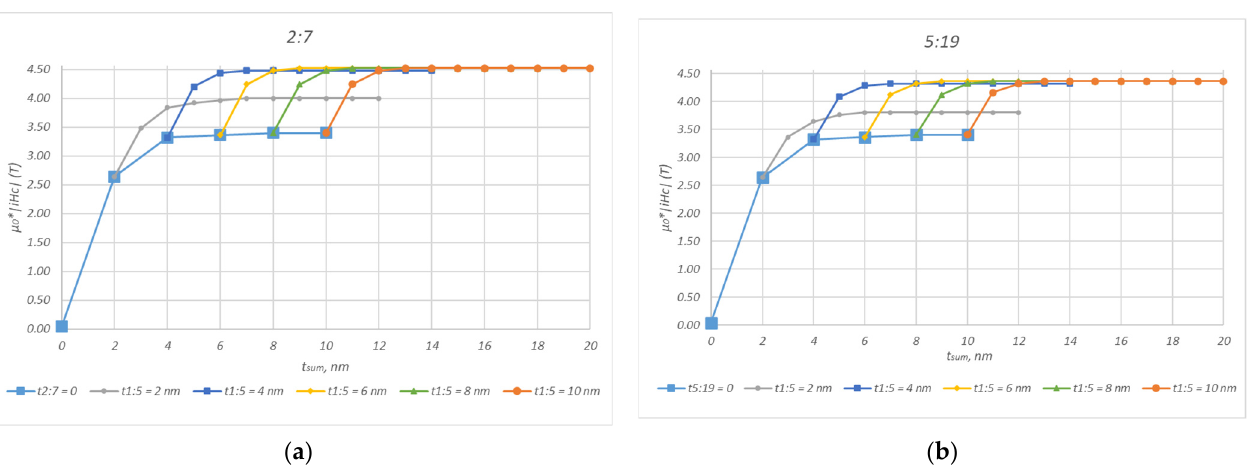
Figure 3. Calculated coercive force versus total width of cell boundary phase layer for the sandwich model 2:17R/ x : y R/1:5H/ x : y R/1:5H/2:17R, where x : y = 2:7R ( a ) and 5:19R ( b ).